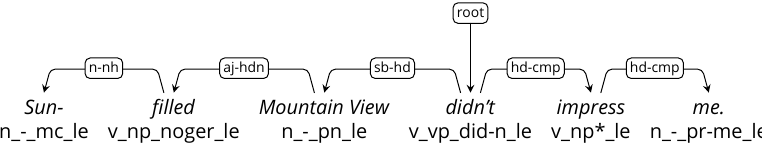
Figure 2: Sample DT bi-lexical dependencies: construction identifiers are gener- alized to major types (cutting at the first underscore) ERG syntactic rules to 48 broad HPSG constructions. 3 The DT